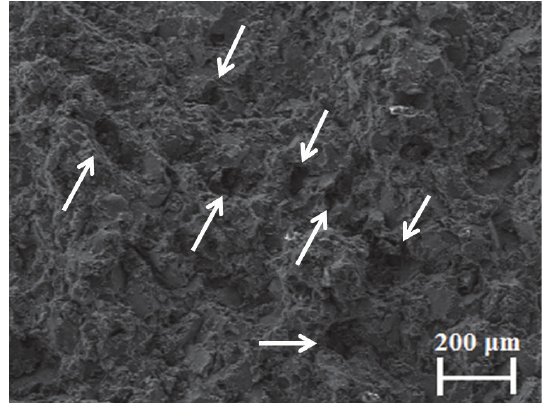
Cu alloy and 9 3 O particles. 2 3